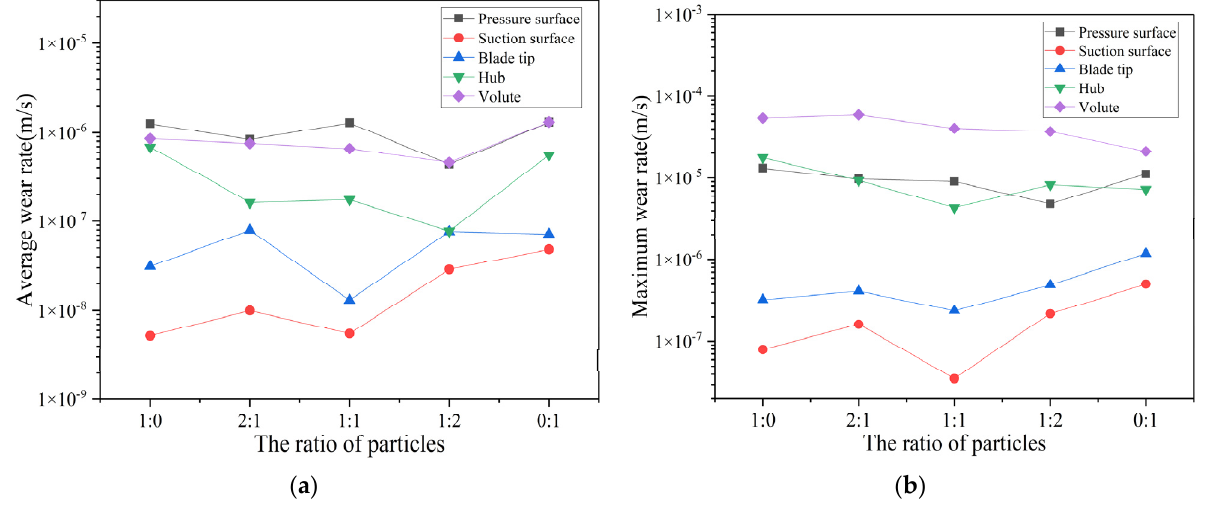
Figure 15. Wear rate curves of different components of centrifugal pump at different particle ratios: ( a ) average wear rate; ( b ) maximum wear rate.